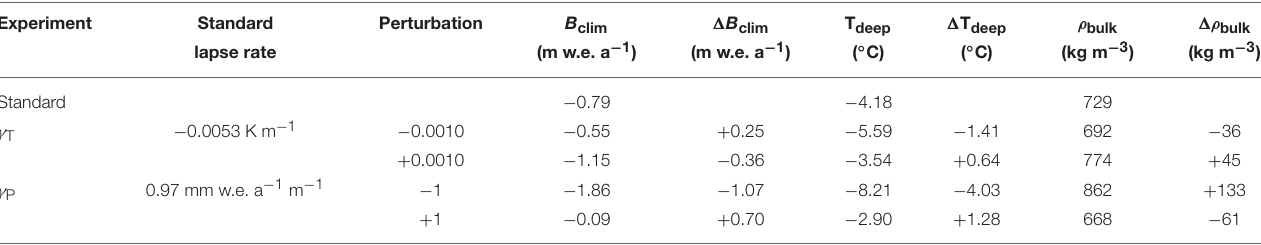
TABLE 2 | Sensitivity of the 2014–2104 mean climatic mass balance ( B clim ), 15-m deep temperature (T deep ) and 0–10m bulk density ( ρ bulk ) to different lapse rates for temperature ( γ T ) and precipitation ( γ P ). Experiment